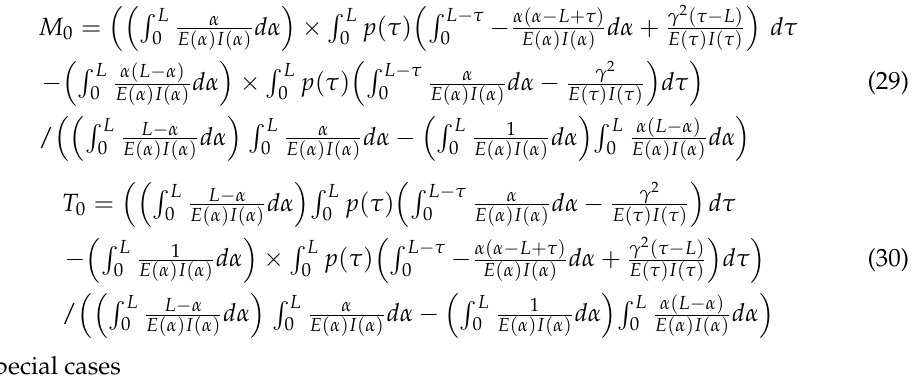
Figure 3 . ( a ) Positive directions in MIV; ( b ) positive directions in SDM.